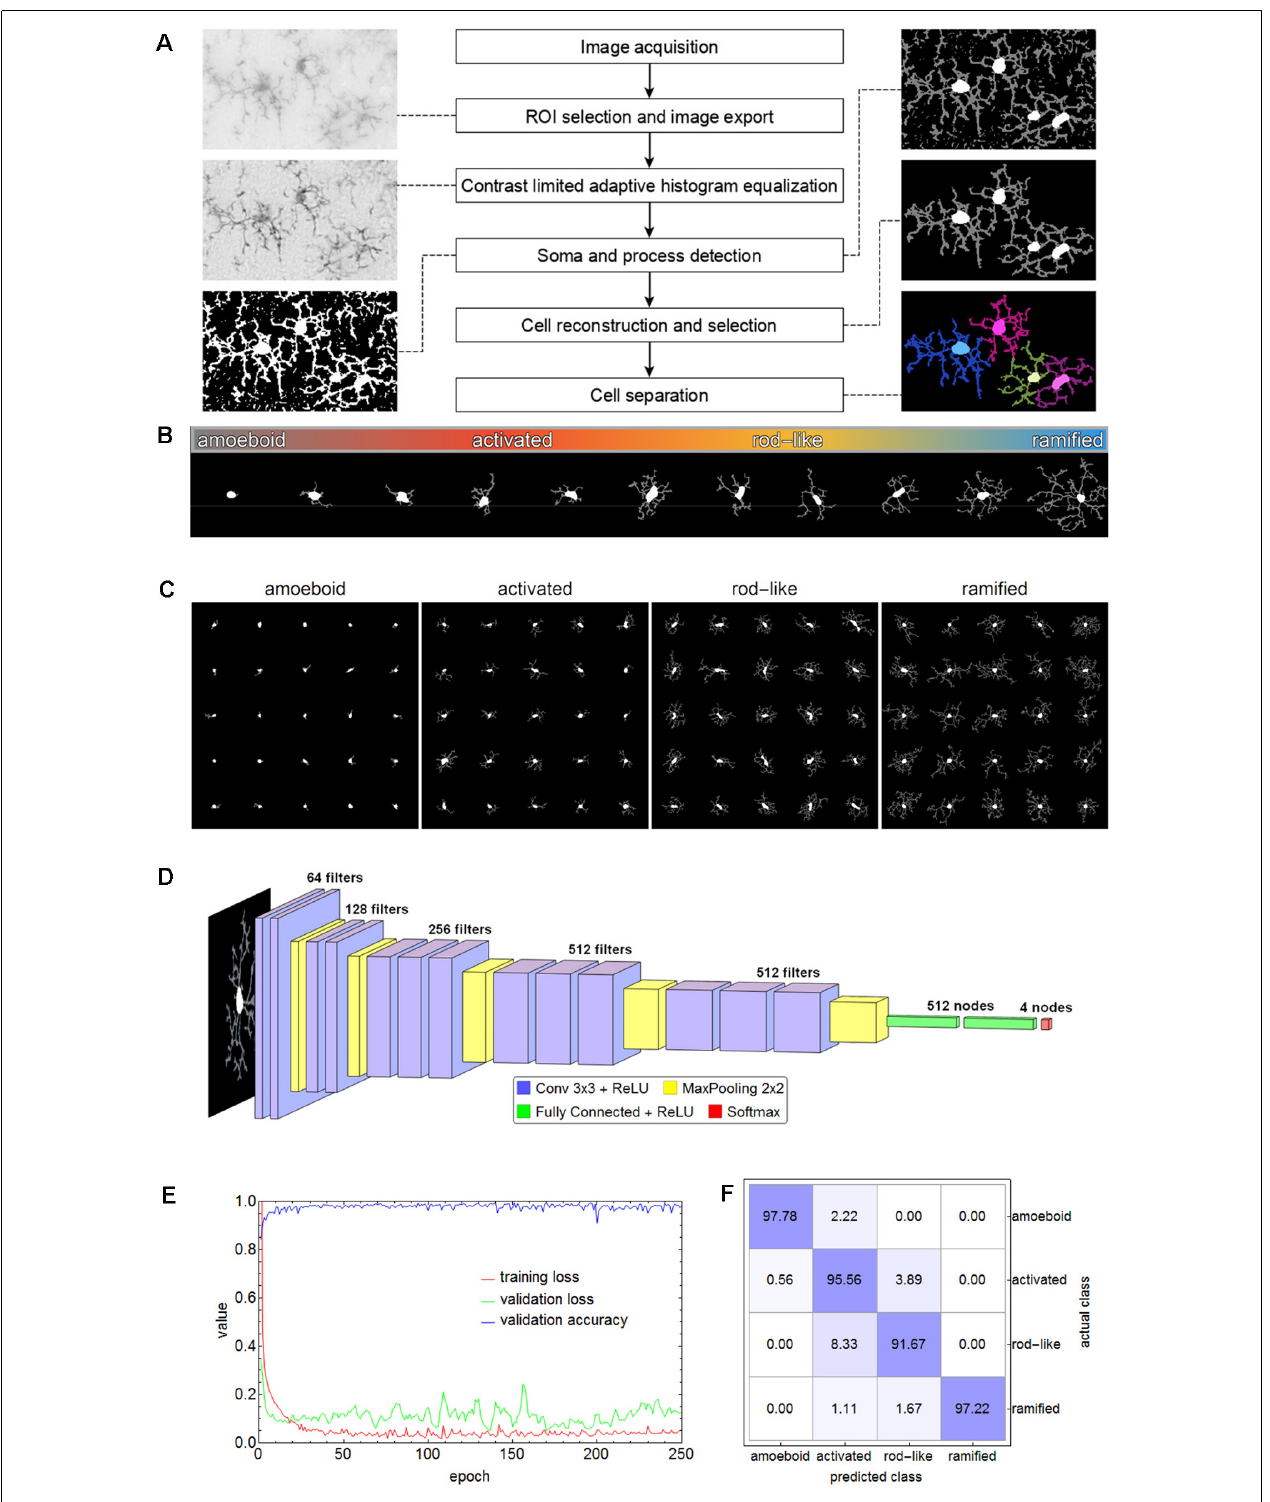
FIGURE 2 | Flow chart of all steps involving the segmentation of microglial cells (A) . The spectrum of the phenotypic diversity of microglial cells after segmentation (B) . Random samples from cells that were manually selected as the basis for cell classification (C) . The convolutional neural network (CNN) based on the VGG-16 architecture that was used for cell classification (D) , along with the performance parameters (log-loss and accuracy) during the training (E) and the confusion matrix for the test set (F) with an overall accuracy of 95.56%.